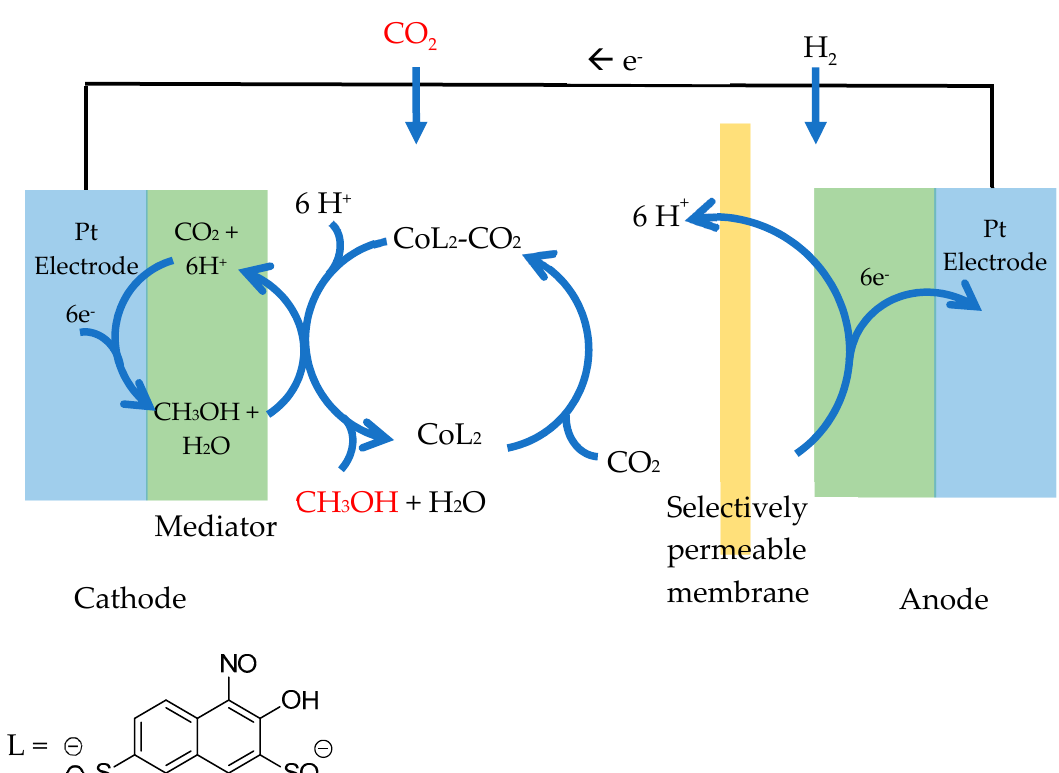
Figure 11. An adapted diagram to show the Catalytic reduction of CO 2 to methanol. Overall equation: CO 2 + 3H 2 → CH 3 OH + H 2 O [72].